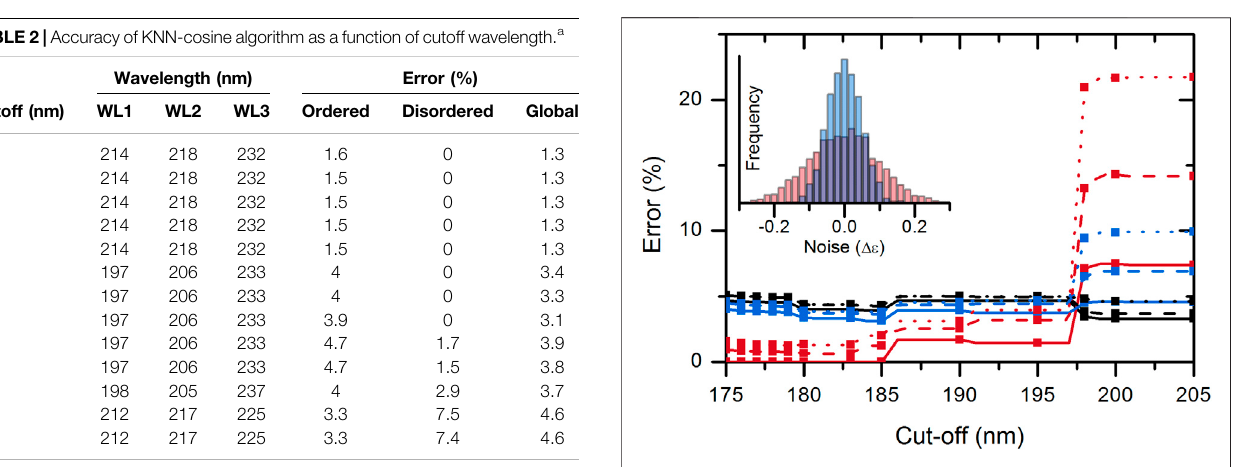
FIGURE 4 | Accuracy of the KNN-cosine method as a function of wavelength cutoff. Error on disordered (red) and ordered (black) proteins and the global error (blue) are shown with solid curves for the original spectra and with dashed and dotted lines for spectra with added noise of σ = 0.05 and 0.1 M − 1 cm − 1 , respectively. Up to 197 nm cutoff, the “ 197-206-233 nm ” triplet and above 197 nm, the “ 212-217-225 nm ” triplet were used for